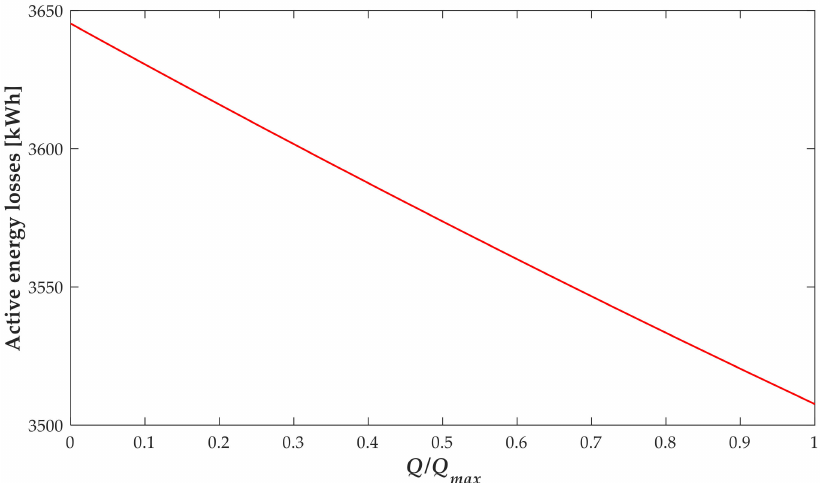
Figure 11. Change in active daily losses in function of reactive power from public